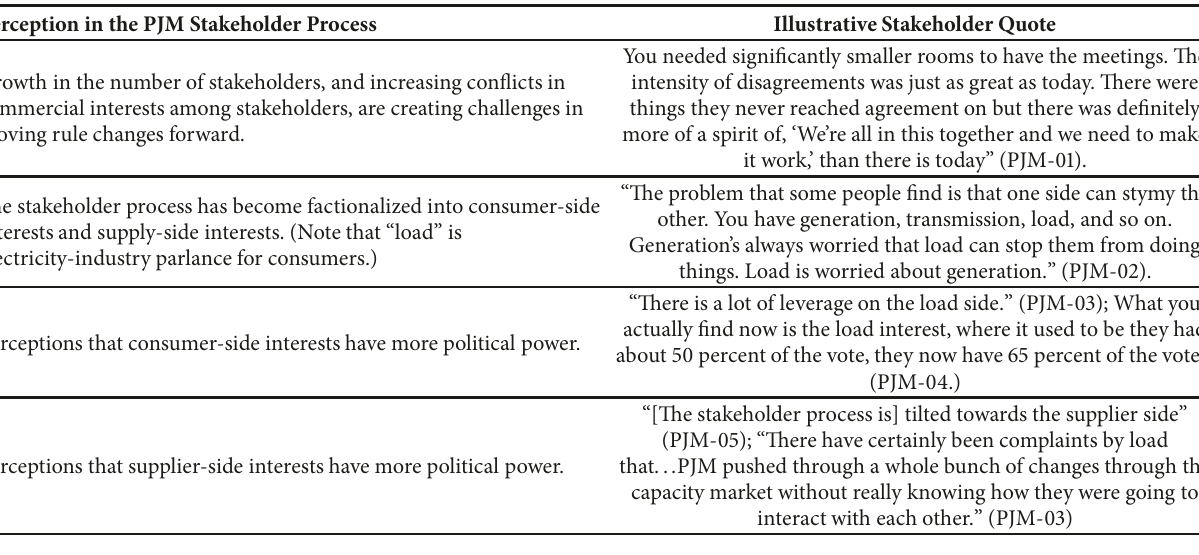
Table 3: Summary of PJM Stakeholder